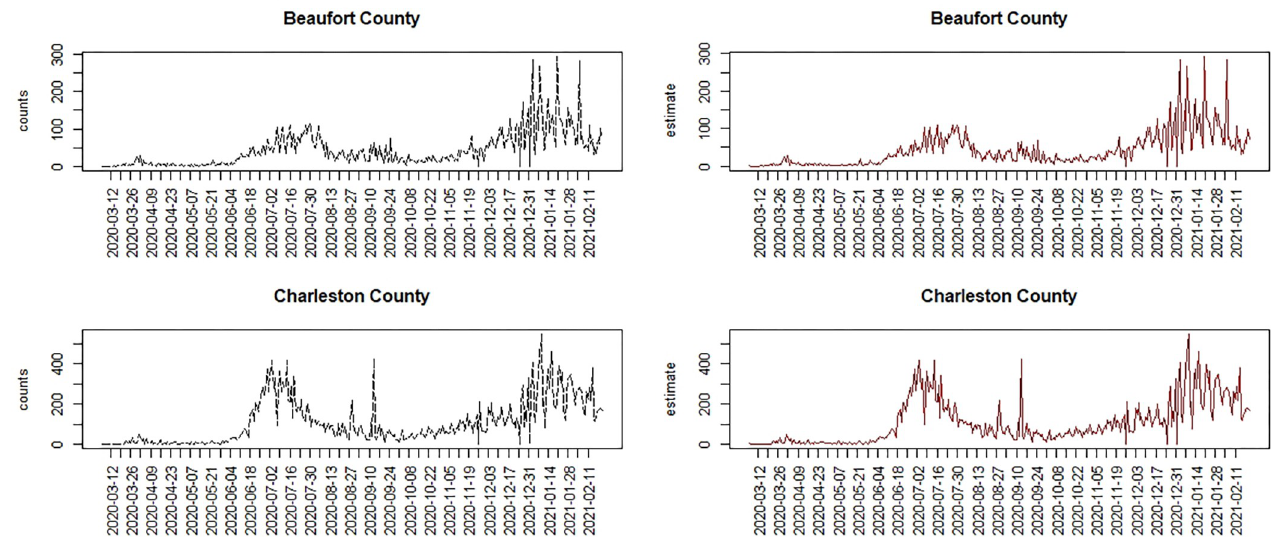
Fig 4. Comparison of two SC counties under a model with time varying random effect and time varying precision. Left: Case count; right: Posterior mean estimated risk.